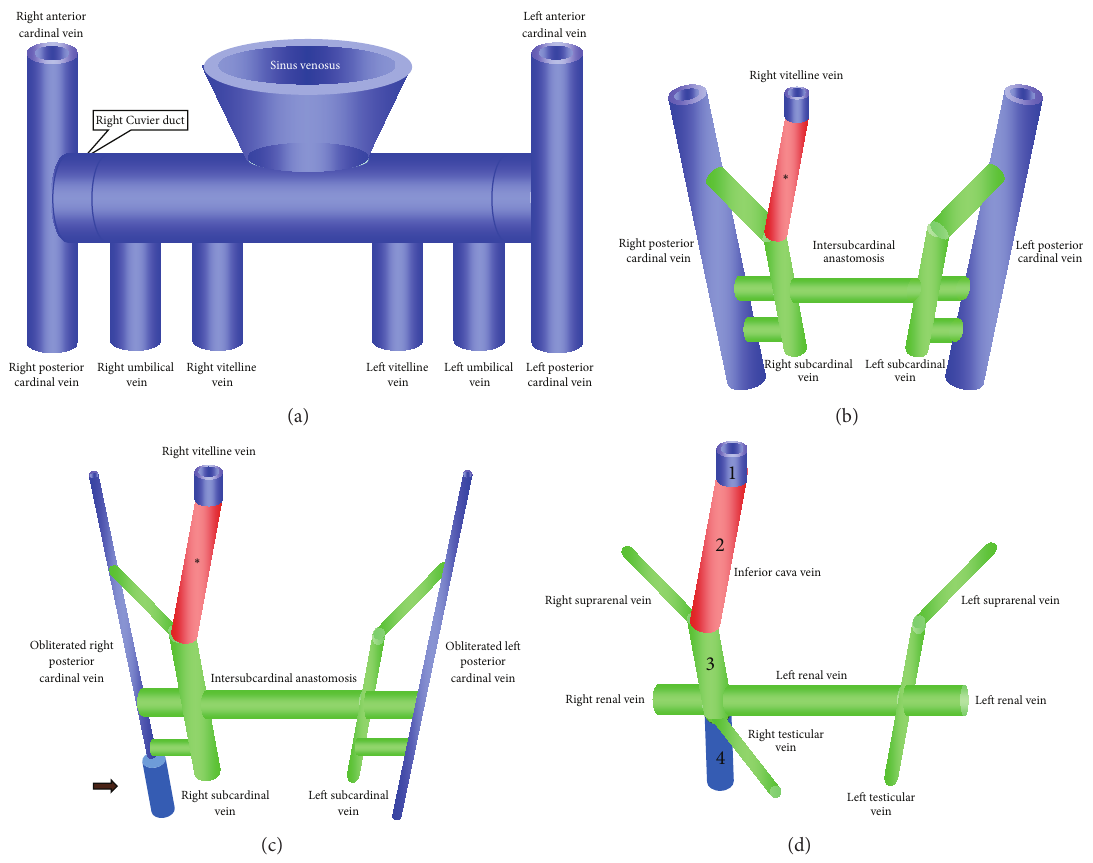
Figure 1: (a) Symmetric stage of the human vascular system development (4-week embryo). Three symmetric paired veins form the basis of the early venous system, draining into the heart: vitelline veins, umbilical veins, and cardinal veins. Both cardinal veins empty into the common duct of Cuvier. (b) Asymmetric stage of the human vascular system development (5-week embryo). Note the persistence of only the right vitelline vein, which, together with the hepatic segment, forms the upper portion of the inferior vena cava ( ∗ ). The posterior cardinal veins appear as paired, symmetrical vessels extending from the duct of Cuvier to the tail region. In the subhepatic region, paired vessels (right and left subcardinal veins) and intersubcardinal anastomosis are formed. (c) At the 6th week posterior cardinal veins are completely obliterated on the left side, whilst, on the right side, only the inferior part remains (arrow). A similar process involves the left subcardinal vein. On the right side, the subcardinal vein is maintained, thus forming the intermediate part of the inferior vena cava. (d) At the end of the developmental processes the right testicular vein drains into the definitive inferior vena cava, formed by four parts (1, 2, 3, and 4) of different origins. The left testicular vein drains in the left renal vein, derived from the intersubcardinal